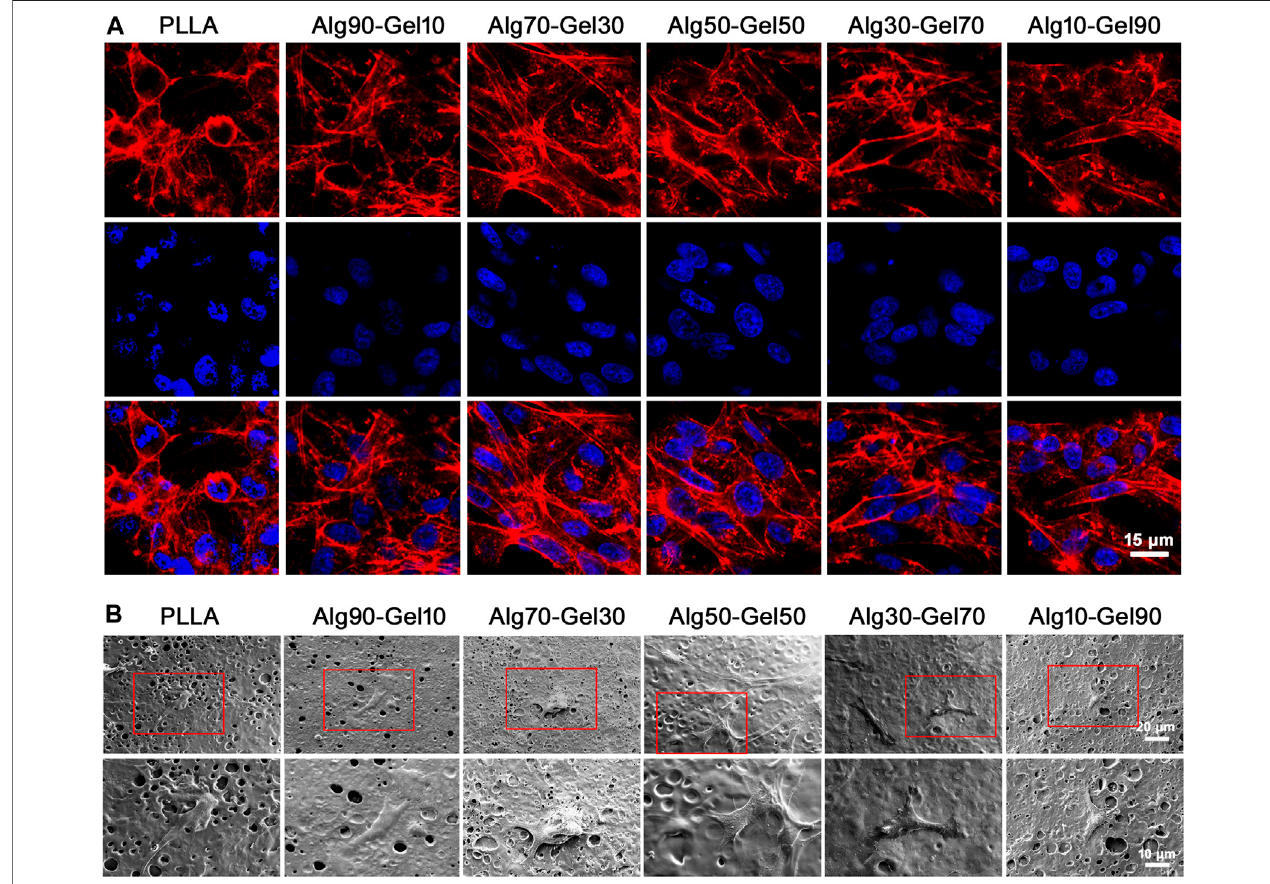
FIGURE 4 | (A) Confocal microscopy images of hBMSCs on different groups at 2 h (red, rhodamine phalloidin; blue, DAPI for nucleus) (scale: 15 μ m). (B) SEM images of hBMSCs in different groups at 3 days.